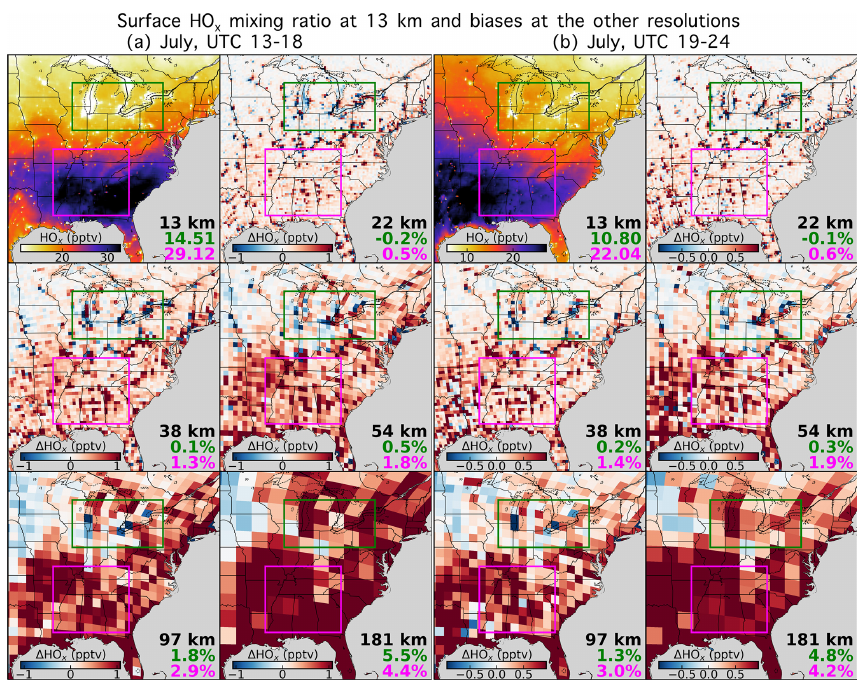
Figure A2. Similar to Fig. 1c but for HO x in the morning ( a 13:00–18:00UTC or 07:00–12:00CST) and afternoon ( b 19:00–24:00UTC or 13:00–18:00CST), respectively.